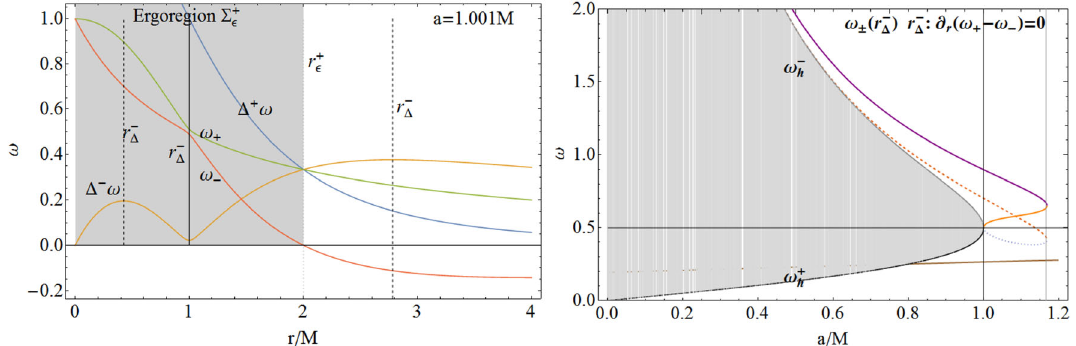
Fig. 7 Right panel: plane ω − r for a NS with spin a = 1 . 001 M . The plots are for the frequency difference (cid:2) − ω ≡ ω + − ω − , the sum (cid:2) + ω ≡ ω + + ω − , and the killing bottleneck for the surfaces ω ± . The